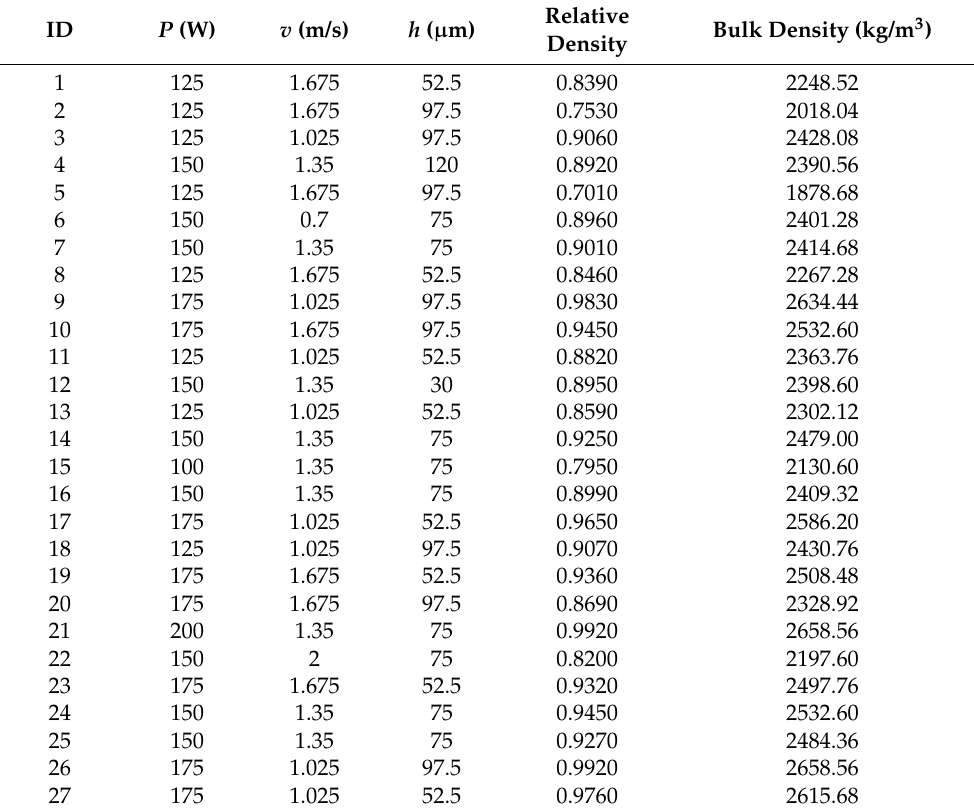
Table A4. Manufacturing parameters and experimental data adapted from [18]. Complementing